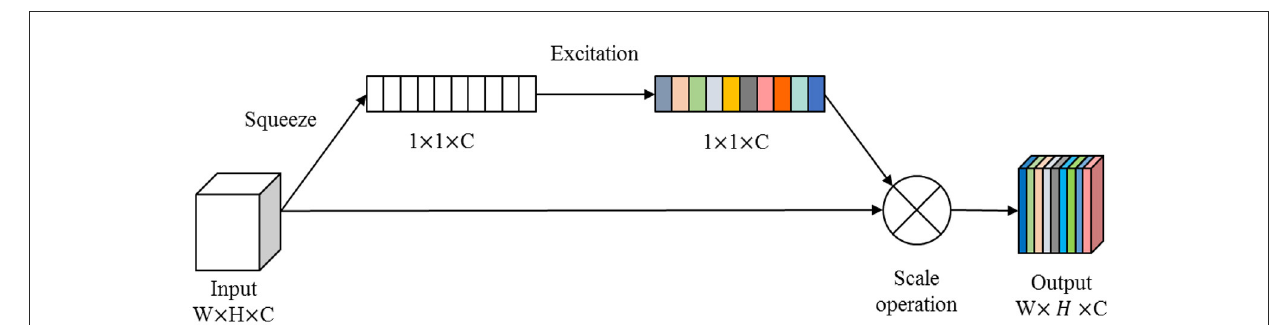
FIGURE5 The architecture of the SE